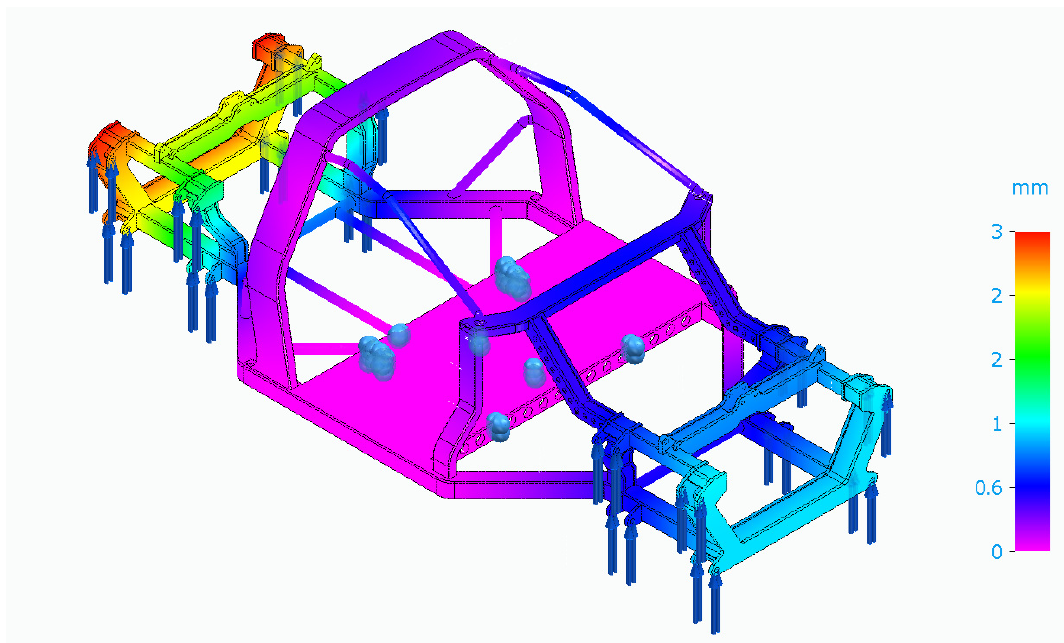
Figure 23. FEM Analysis with 1200 N load and 0.9 mm deformation.